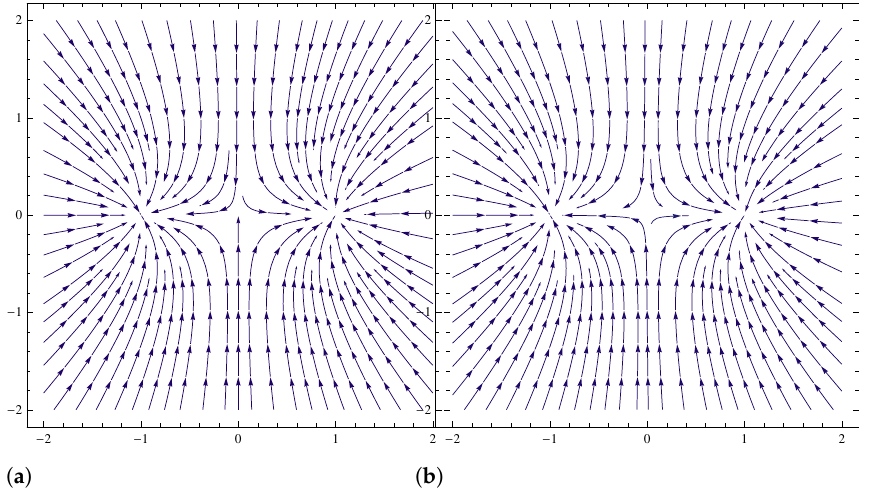
Figure 5. Streamline for Example 2, F 2 ( z ) = ( 2 z − 1 ) method (9), ( b ) Proposed Continuous method (13).